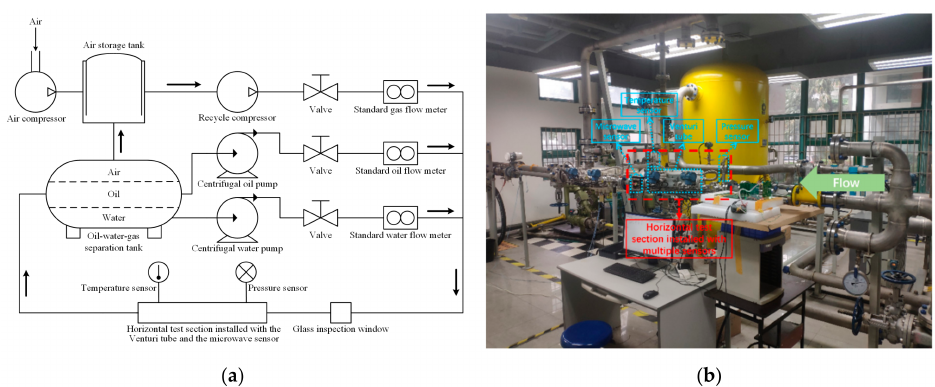
Figure 1. The schematic diagram and picture of the experimental system. ( a ) The schematic diagram; ( b ) The